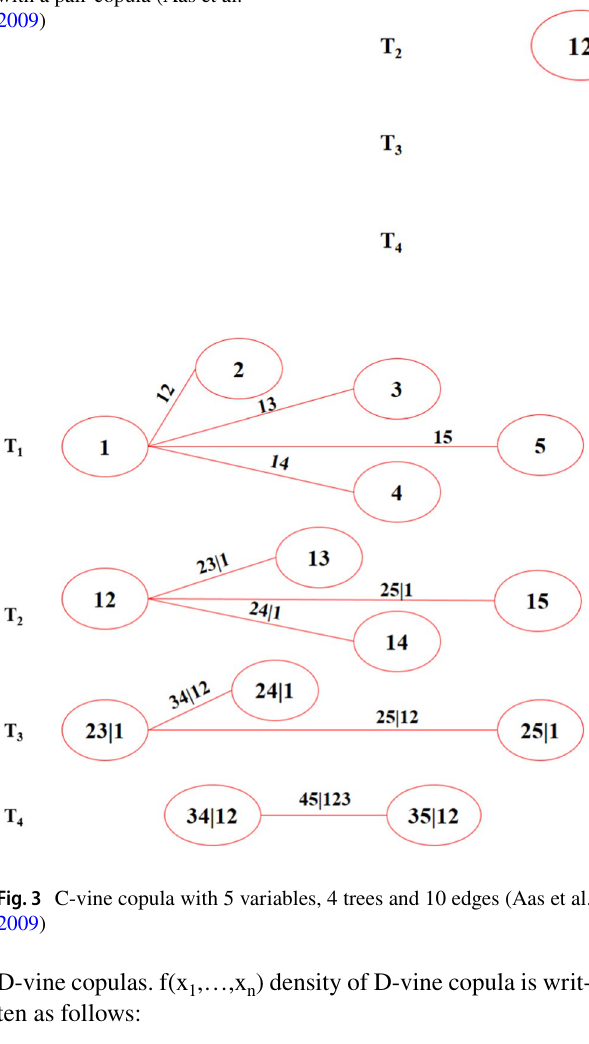
Fig. 2 D-Vine with five vari- ables, four trees and ten edges. Each edge may be associated with a pair-copula (Aas et al. 2009)